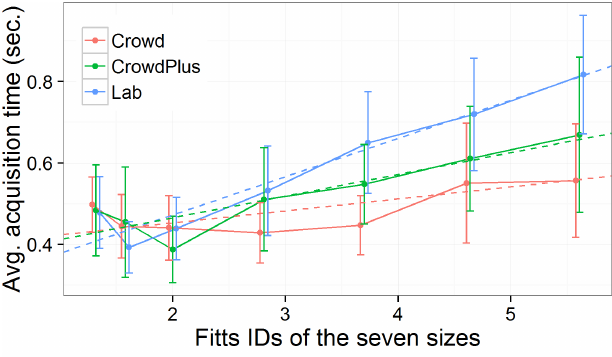
Figure 5. Target acquisition time by target size (in Fitts’ IDs) and group including 0.95 confidence interval error bars